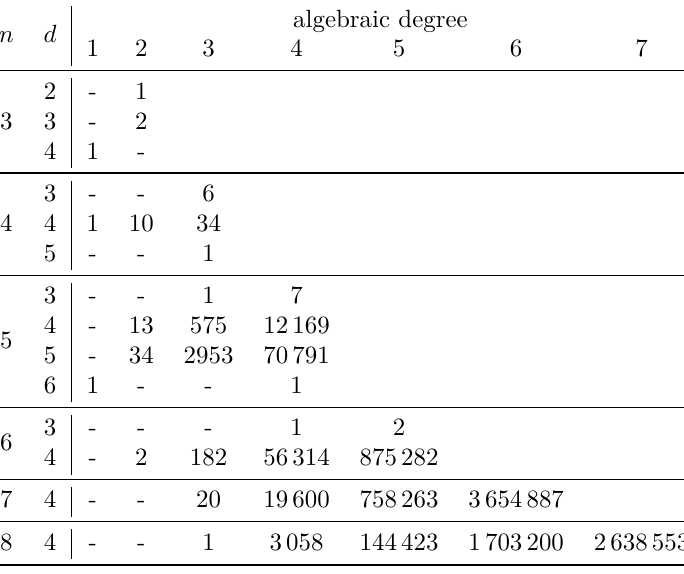
Table 5: Number of the balanced Boolean functions in F n,d with categorized by their ANF algebraic degree; i.e., number of full-dependent n -bit balanced Boolean functions with given degree and latency complexity up to the extended bit permutation